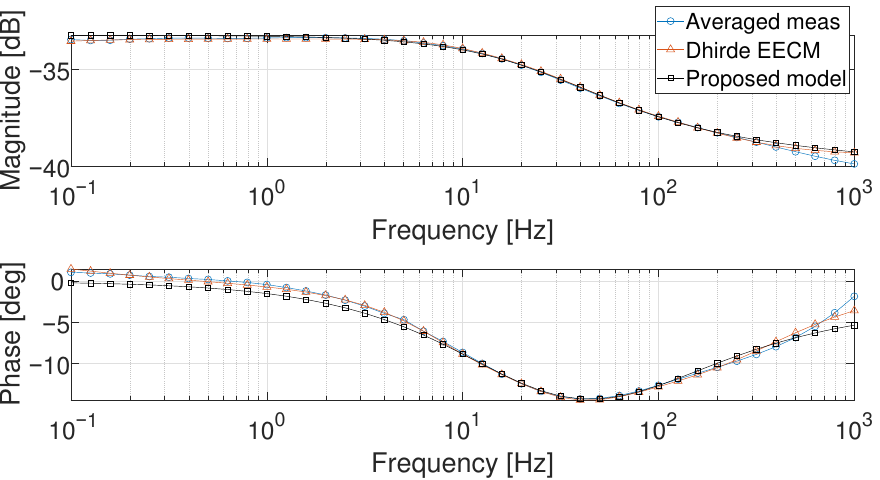
Figure 26. Bode diagram of the averaged measurement (circle marked), the Dhirde et al. model (triangle marked), and the proposed model of (8) (squared marked) at